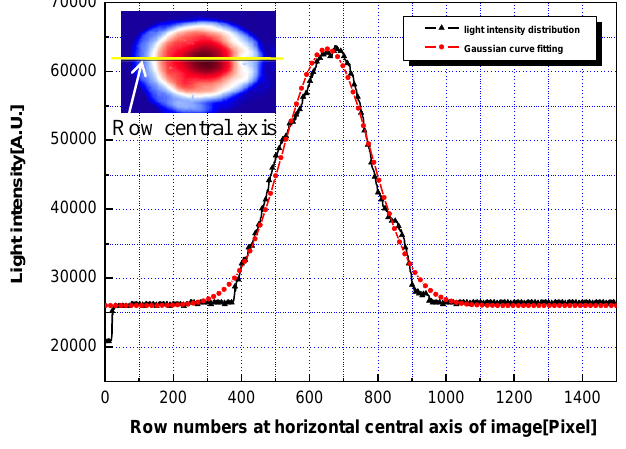
Figure 2. Beam profile test results. ( a ) Gaussian curve fitting analysis; ( b ) Standard normal